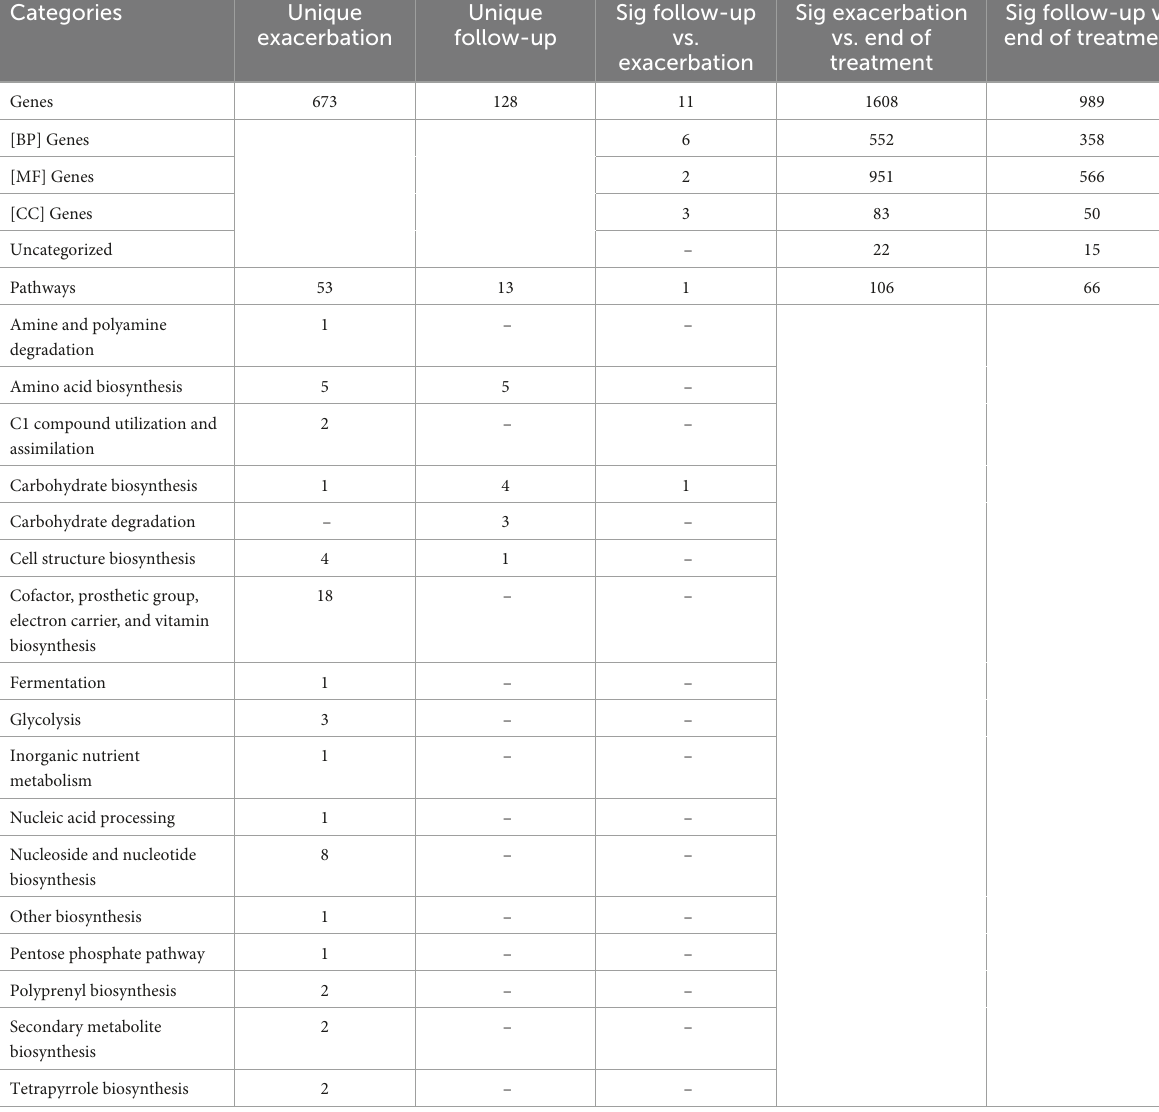
TABLE 3 Gene and pathway abundance of clinical status comparisons (across respective